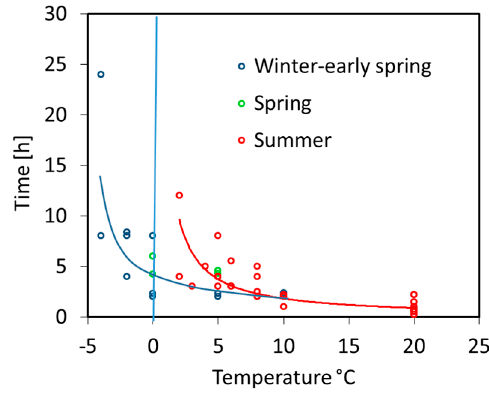
Figure 4. Delay of the germination start in hours depending on temperature for the different phenotypes. Trend lines show the power trendline for the increase in lag time with decreasing temperatures in summer flowering species (red, y = 19.8 x − 1.04 ) and winter and spring flowering species (blue, y = 13.5 x − 0.76 ).